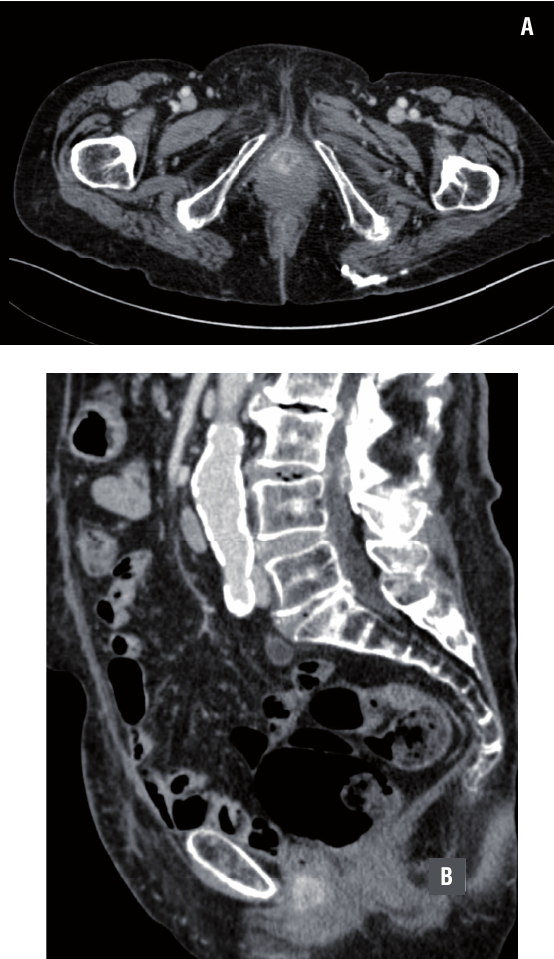
figure 1 - vaginal cuff recurrence in an 82 year old female. After undergoing radical cystectomy and lymphadenectomy (pT3aN0 tumor), patient subsequently developed symptomatic vaginal blood spotting. The cT scan demonstrates a solid mass originating from the vaginal cuff. Surgery was performed and fi nal pathology showed a recurrence of urothelial carcinoma originating from the vaginal